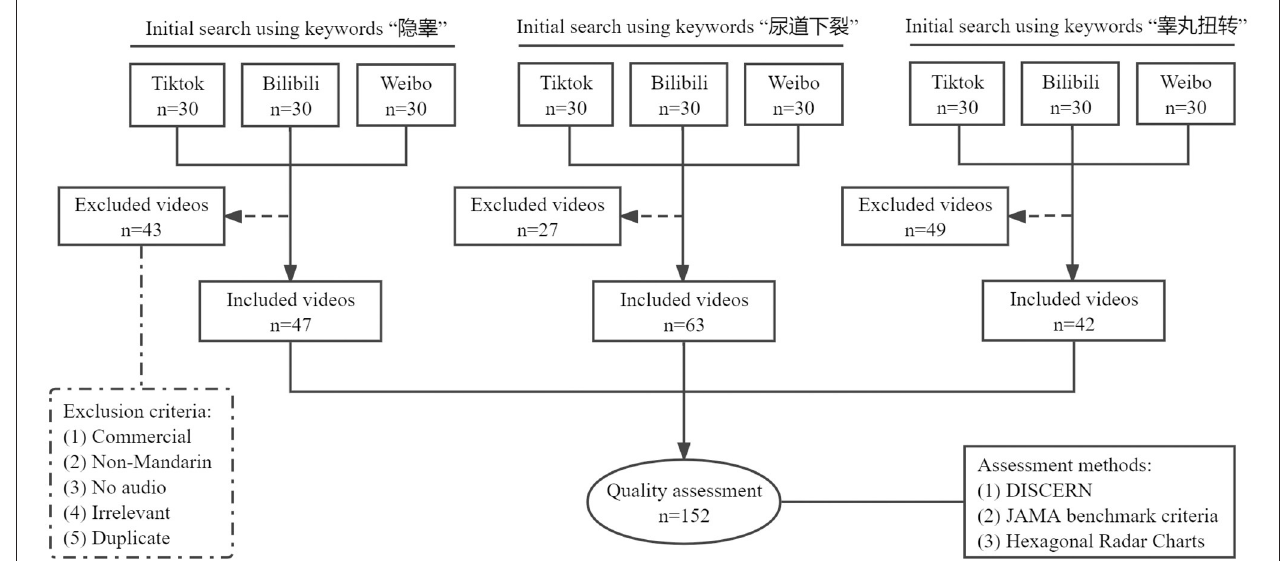
FIGURE 1 | Flowchart of the selection of internet videos for analysis.